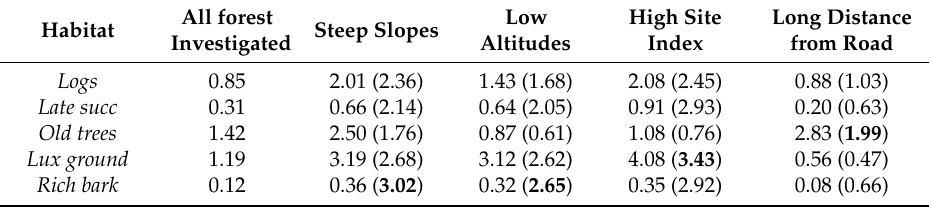
Table 5. The proportion (%) of investigated area (development classes 4 and 5) consisting of different habitat types, and the proportion of the same habitat types on the 25% steepest slopes, lowest altitudes, highest site index, and longest distance from road. The numbers in parentheses are the ratio between a given entry and that of all investigated forest, i.e. , number of times higher cover of a habitat type. The highest value for each variable is denoted in bold. Late succ = Late succession of deciduous trees , Lux ground = Luxuriant ground vegetation , Rich bark = Trees with nutrient-rich bark